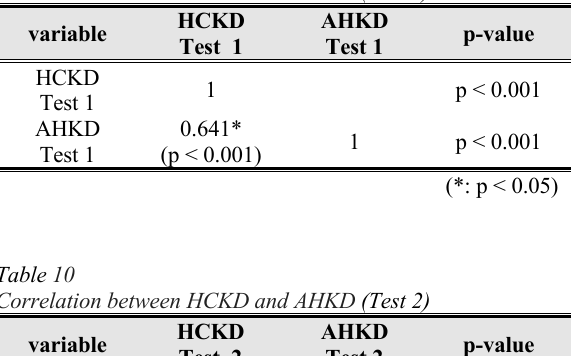
Correlation between HCKD and AHKD (Test 1)